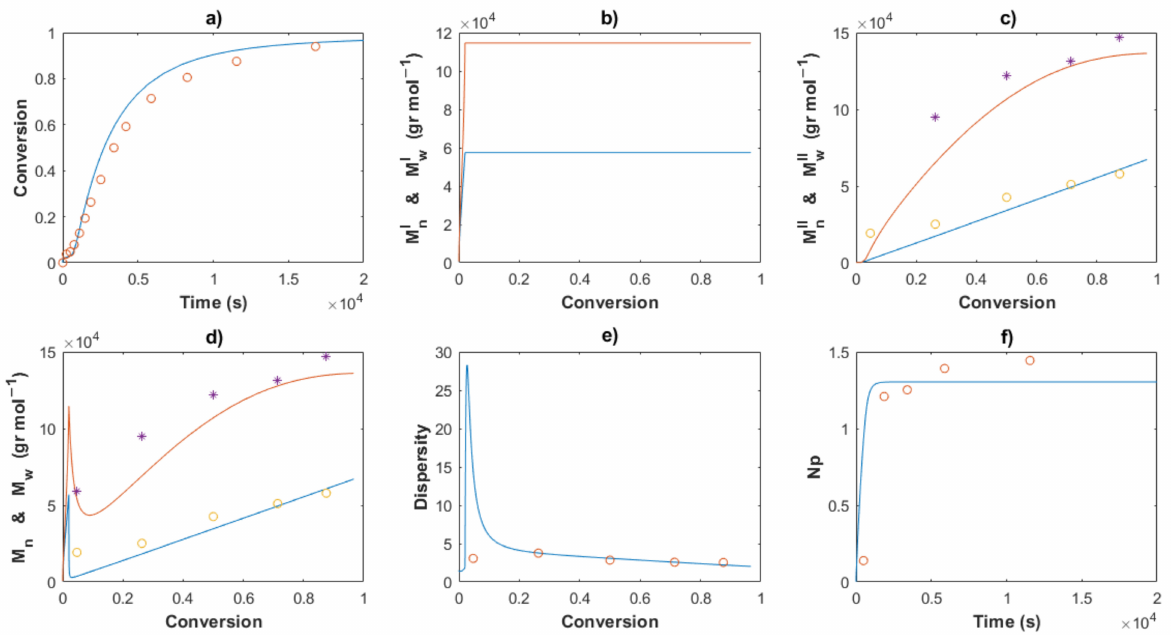
Figure 11. Comparison between the experimental data (symbols) and the model solutions (lines) for Exp 2: ( a ) Conversion profiles, ( b ) M nI and M wI versus conversion, ( c ) M nII and M wII versus conversion, ( d ) M n and M w versus conversion, ( e ) Dispersity, ( f ) Np versus